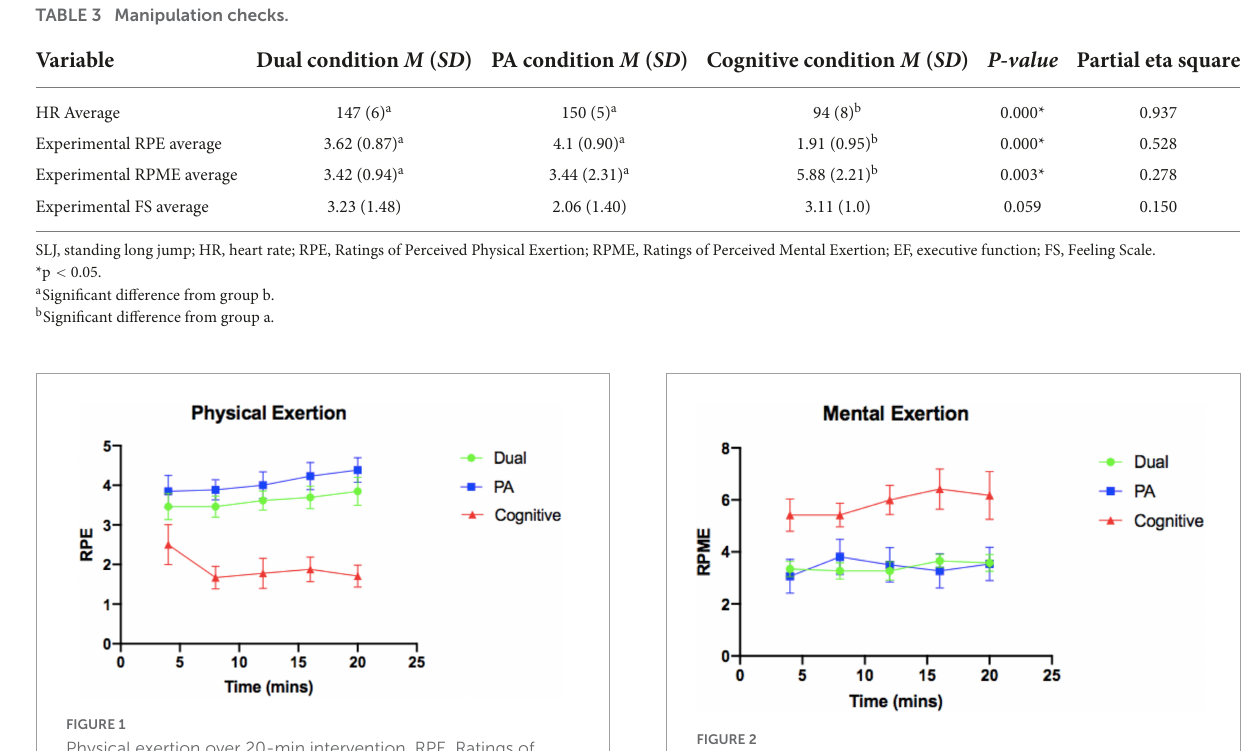
TABLE 3 Manipulation checks.